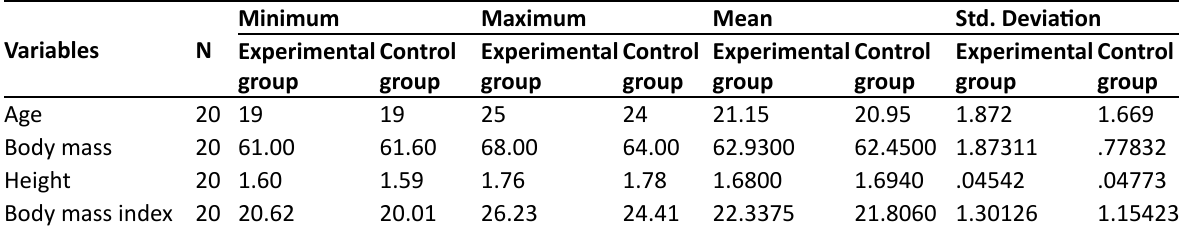
Table 1. Participants demographic characteristics